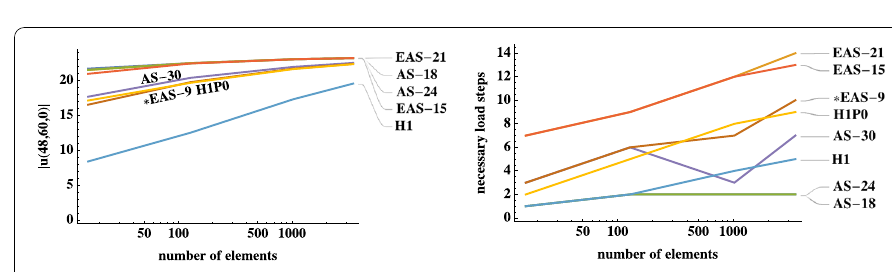
Fig. 17 Cook’s membrane problem, displacement convergence (left) and the number of necessary load steps (right)